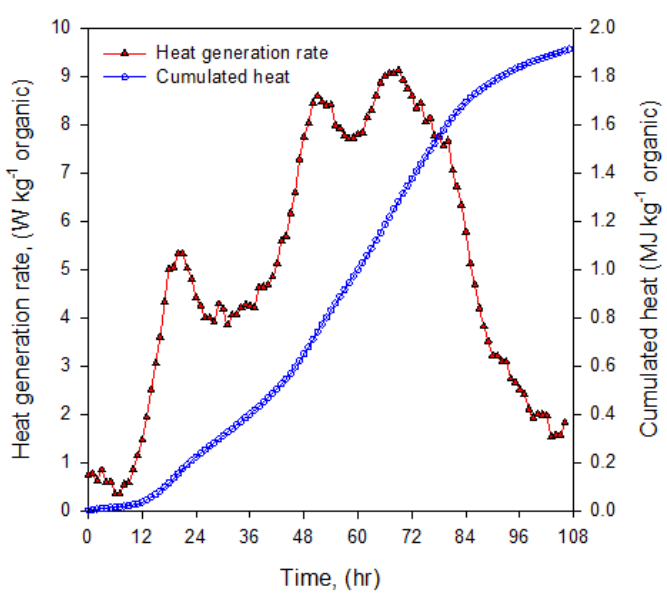
Figure 6. Time course for the heat generation rate (W) and the cumulated heat (MJ), per kg of organic matter, during the composting process.